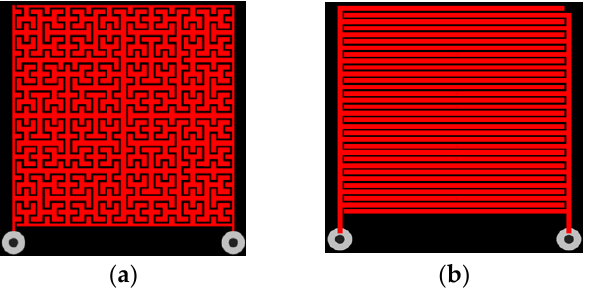
Figure 6. Structure diagram of sensor plate. ( a ) Fractal electrode; ( b ) ordinary Euclidean electrode (interdigital electrode).